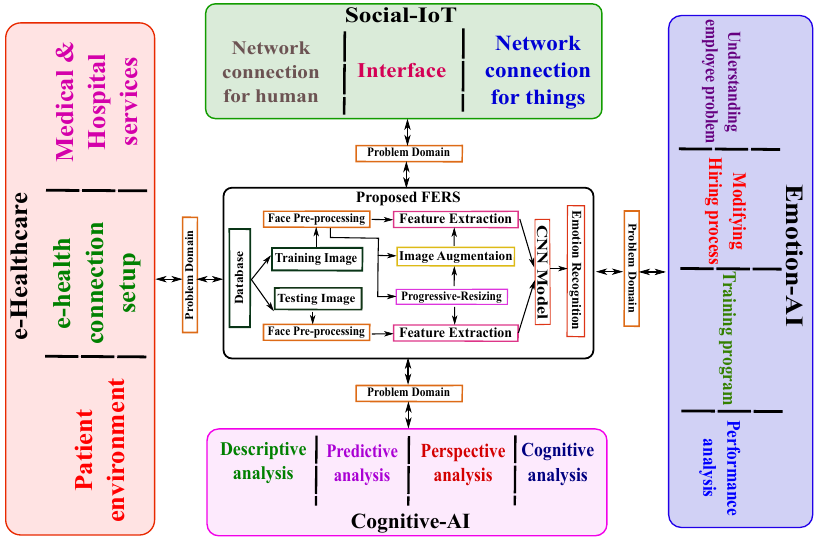
Figure 2. Block diagram of the proposed